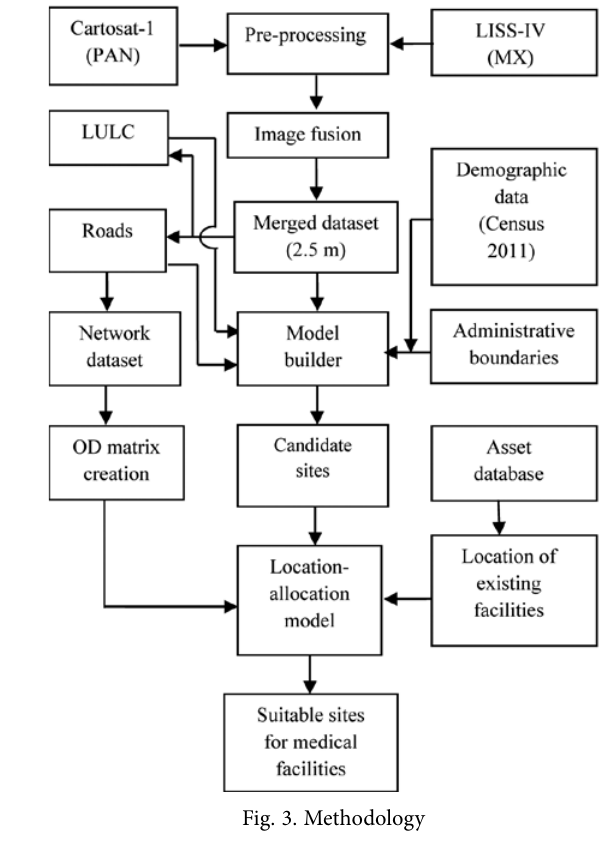
Fig. 3. Methodology